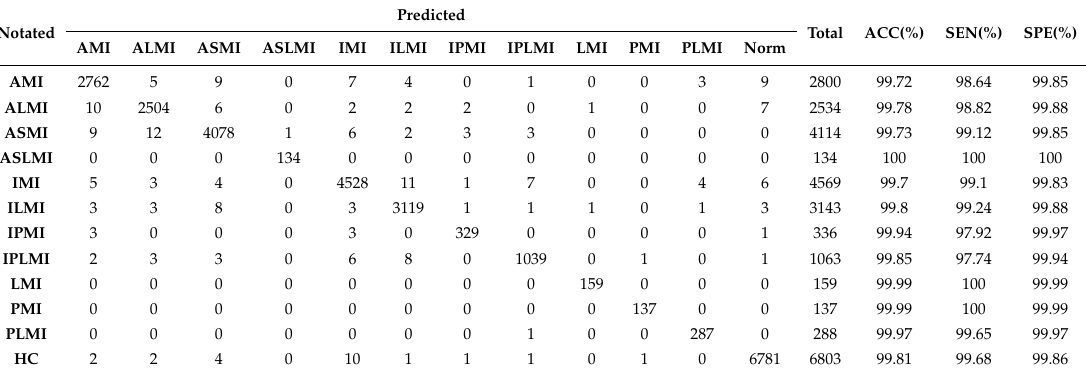
Table 9. Confusion matrix for MI classification using derived Frank XYZ